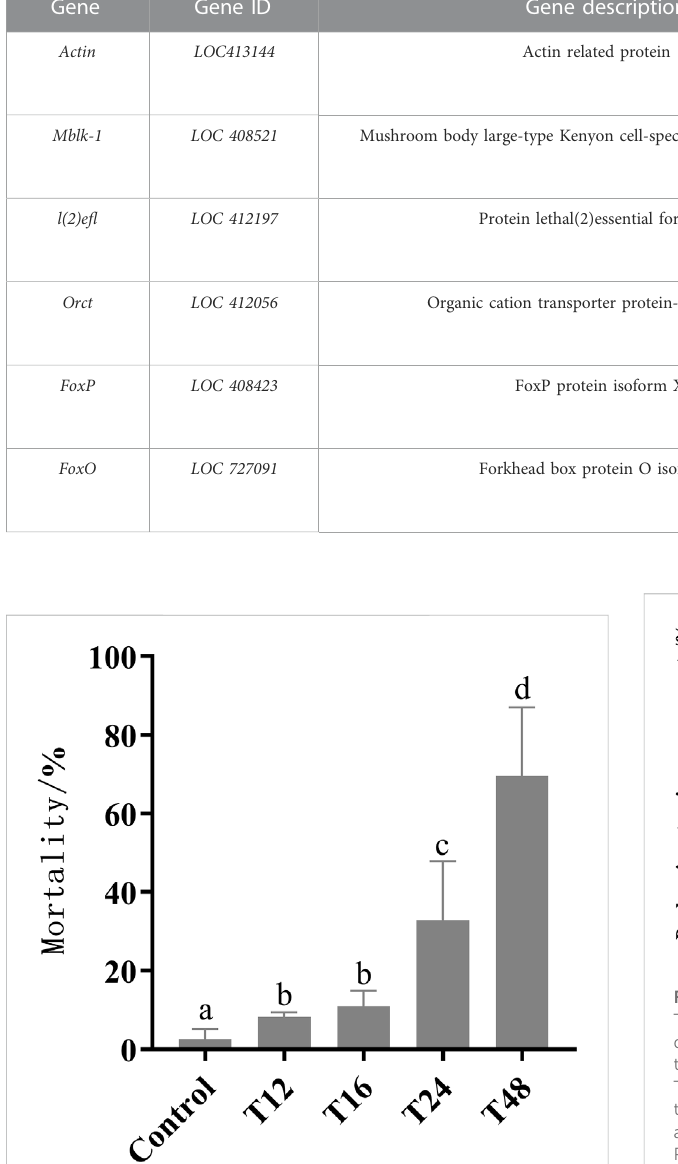
FIGURE 1 The sample size of control group, T12, T16, T24, and T48 were 110, 49, 65, 59, and 51 respectively. Mortality (mean value ± standard deviation, ‾ X ± SD) of early pupa experienced with 20 ° C for 12, 16, 24, and 48 h. The different letters in lower case indicated signi fi cant difference p < 0.05 level.